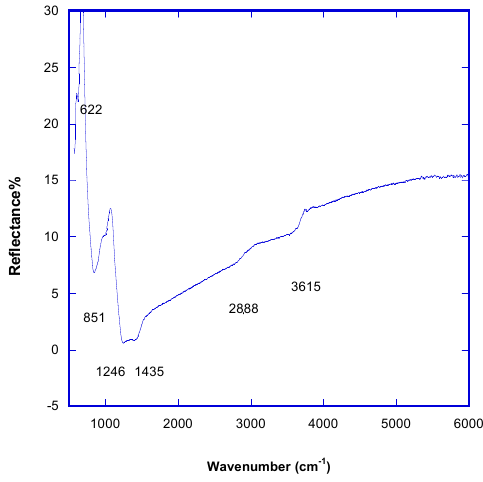
Figure 4. FTIR AlN pre analysis.